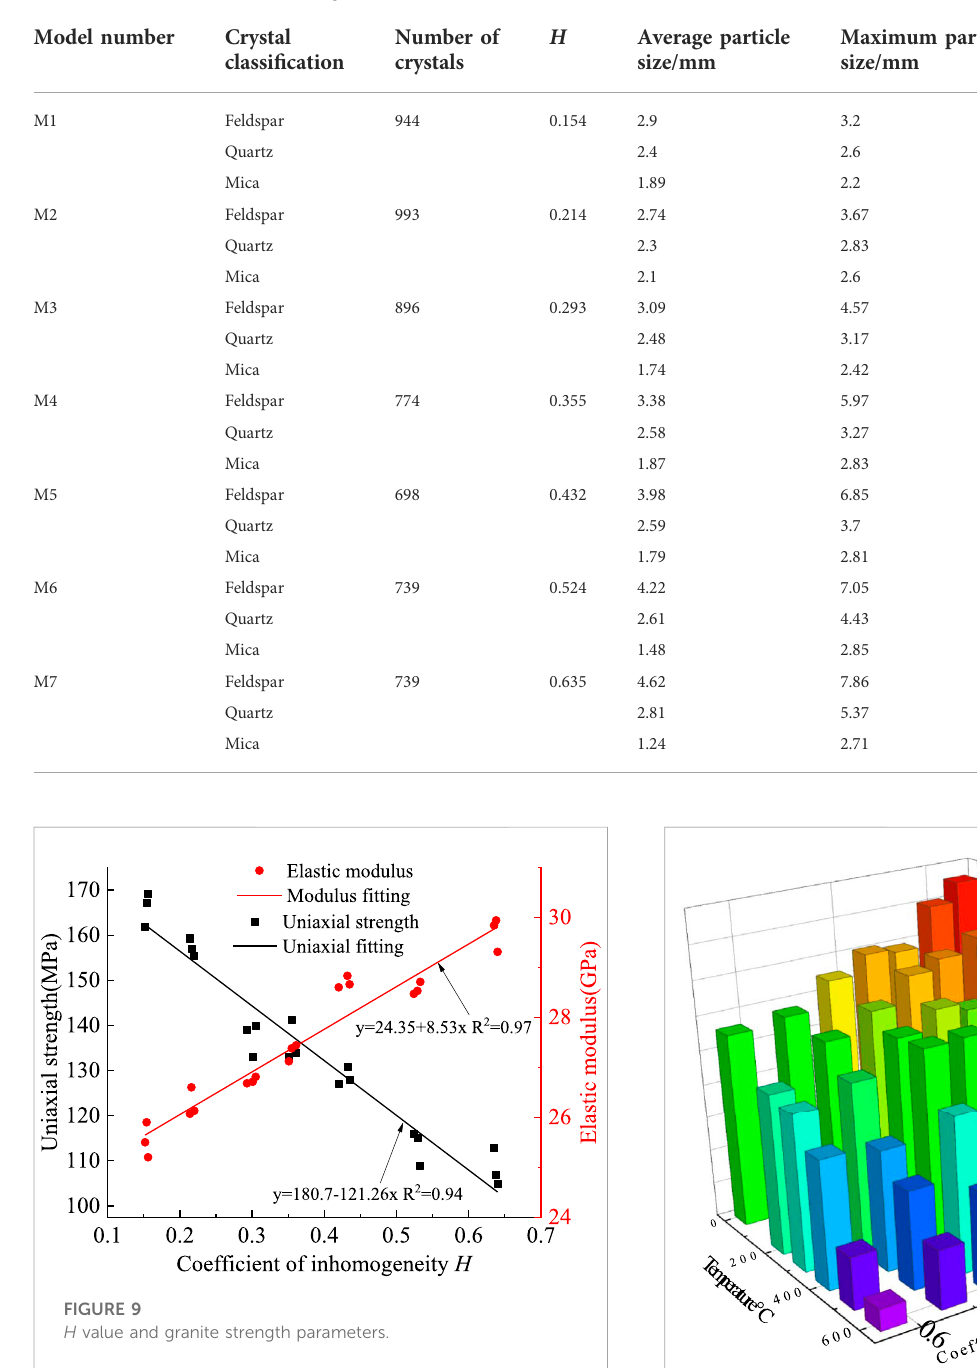
FIGURE 10 Uniaxial strength dependence of inhomogeneity and temperature fi